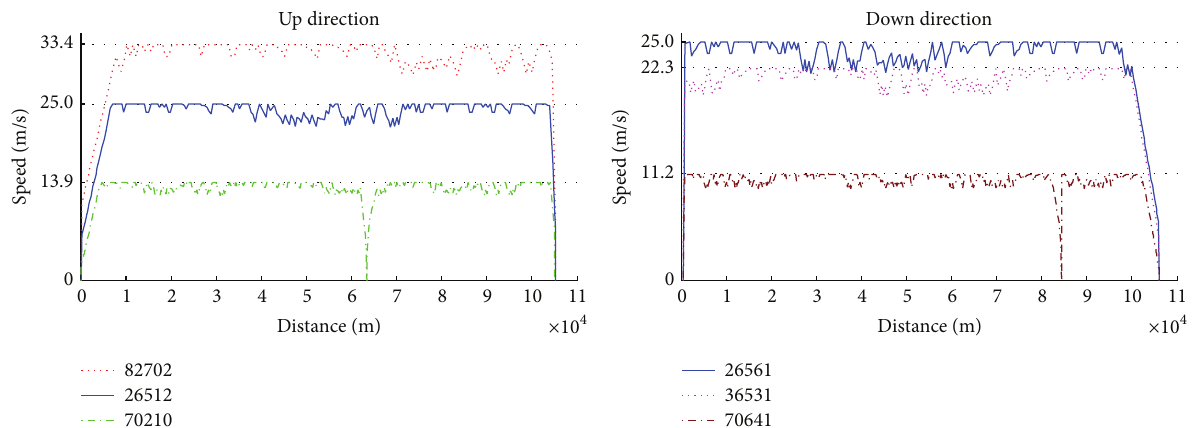
Figure 19: Train speed-distance curve (NCBS: blocking sections 3 and 4 in the left).